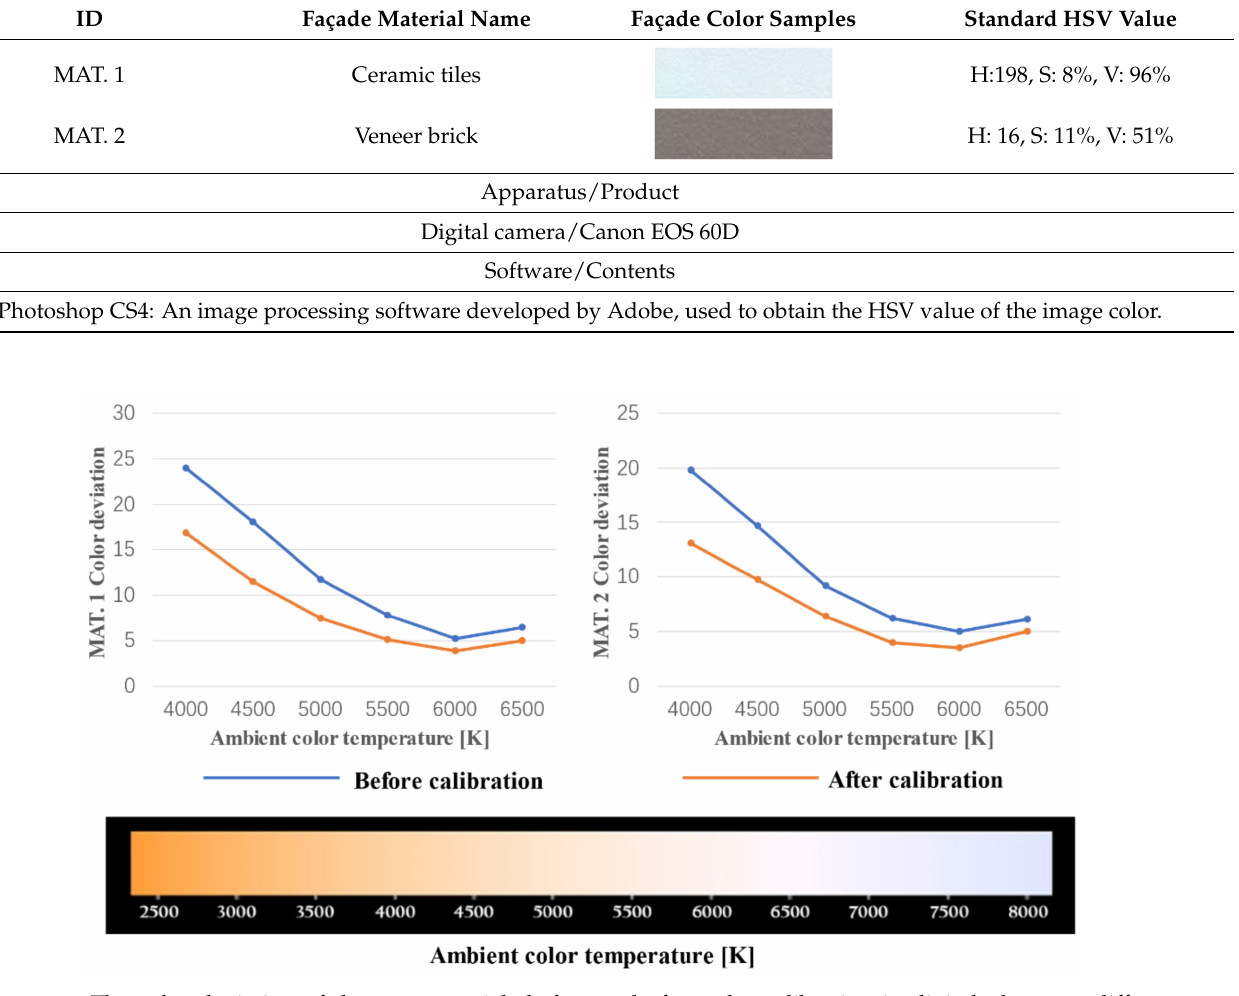
Figure 9. The color deviation of the two materials before and after color calibration in digital photos at different color